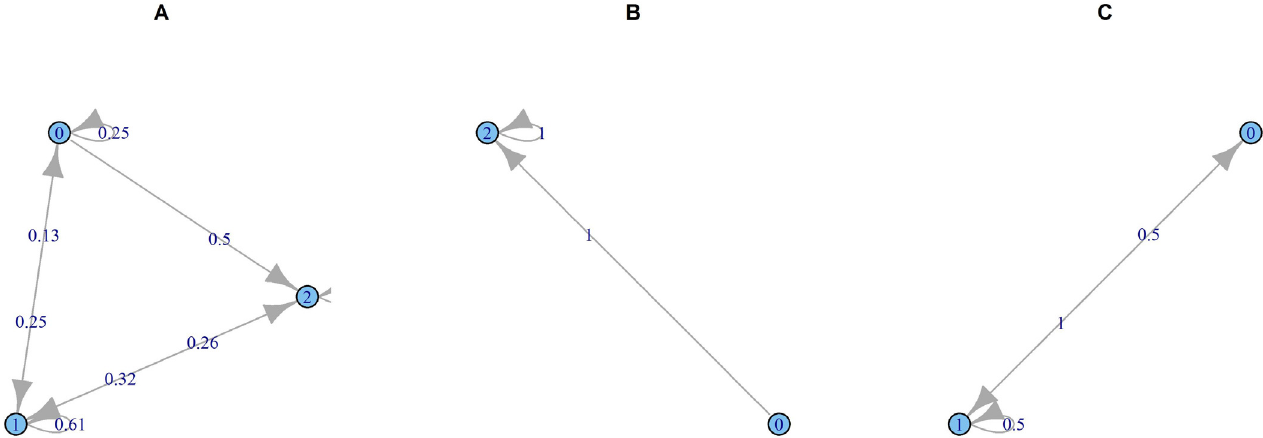
Fig 6. Markov Chain — A-Probability of transition for different winter epidemic states, 0 = non-epidemic, 1 = intermediate, 2 = epidemic; B — When the values of meteorological variables are below the lower thresholds: solar radiation < 32 W/m 2 , temperature < 2°C and AH < 4 g/m 3 ; C- When the values of meteorological variables are above the upper threshold: solar radiation > 74 W/m 2 , temperature > 6°C and AH > 5.8 g/m 3